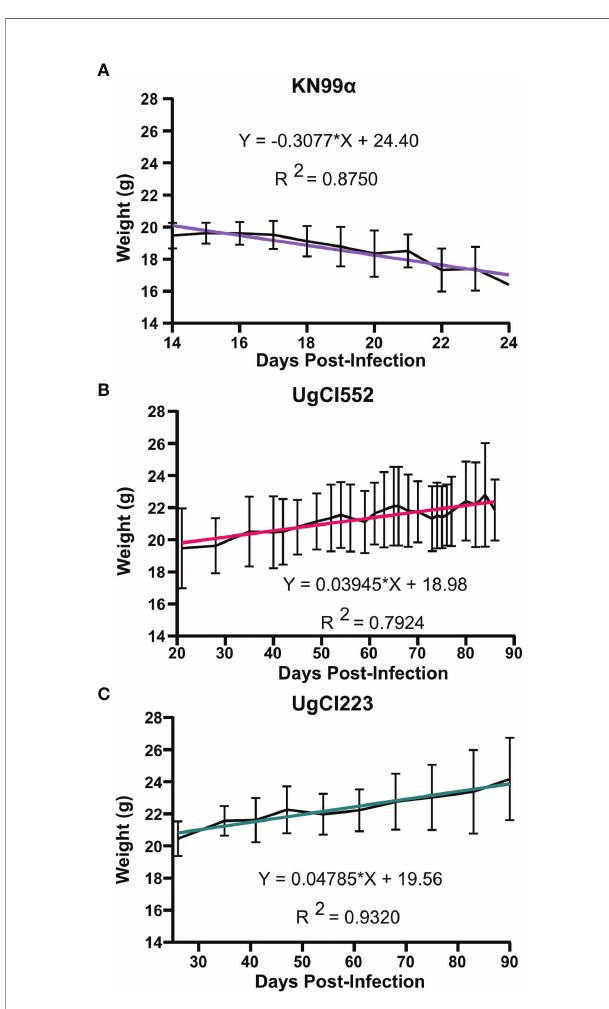
FIGURE 2 | Mice infected with UgCl223 and UgCl552 maintained steady weight gain throughout the course of the infection. C57BL/6 mice were intranasally infected with (A) KN99 a , (B) UgCl552, (C) UgCl223. Mouse weights in grams (g) were tracked until 90 days post-infection for UgCl552 and UgCl223, and 24 days post-infection for KN99 a . Simple linear regression analysis was performed between mean weight of mice (n = 10) and days